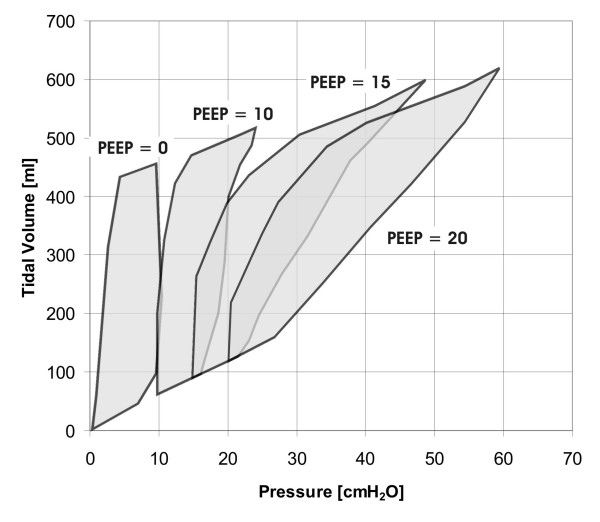
PV curves for different PEEP. The above plot shows the differences in the shapes of PV loops with different PEEP level and same tidal volume. The plot shows the tidal volume and estimated FRC. As can be seen, the compliance gradually decreases as PEEP is increased.